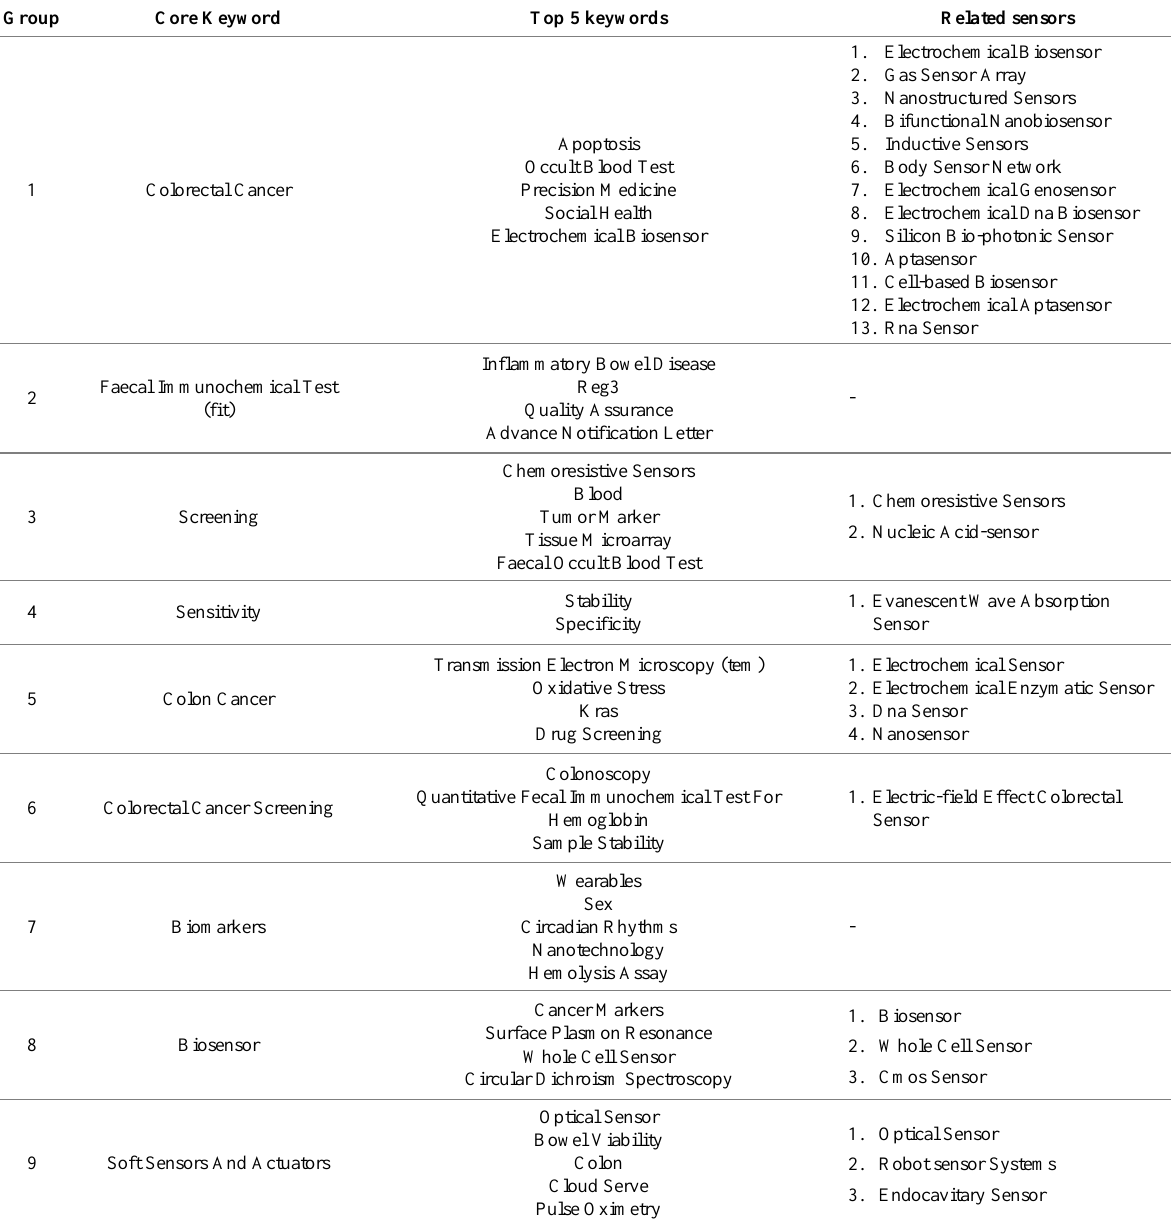
Table 4A. Groups, Core keywords and related sensors in the colorectal cancer network Group Core Keyword Top 5